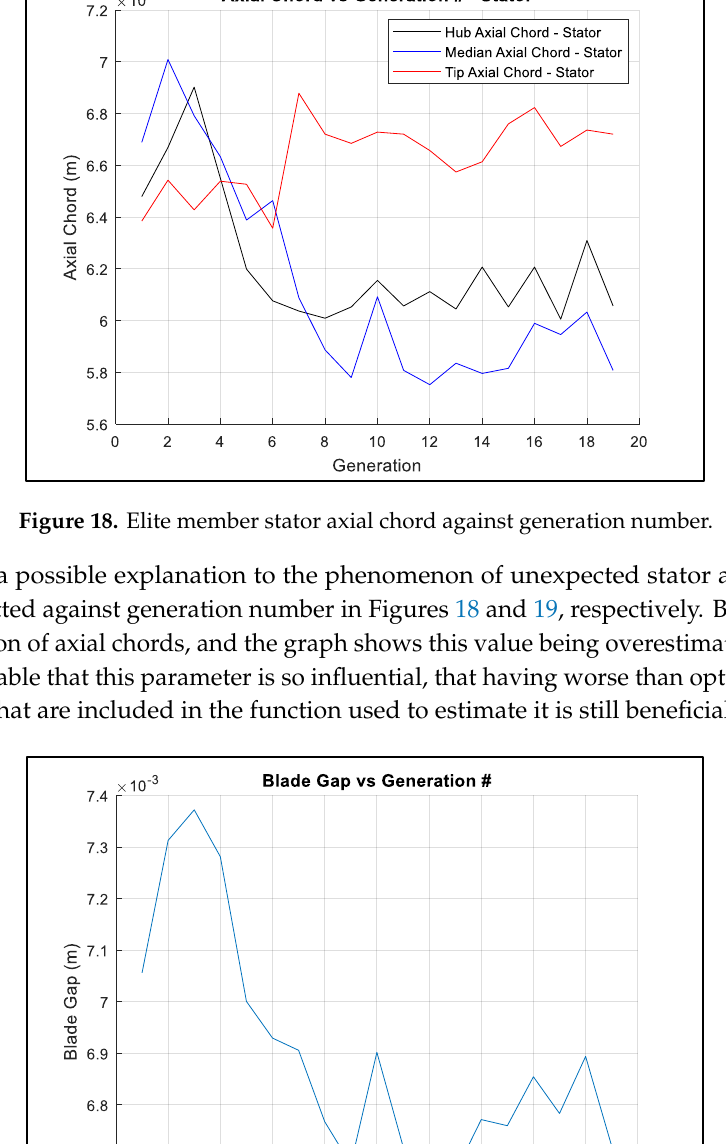
Figure 19. Elite member blade distance against the generation number.